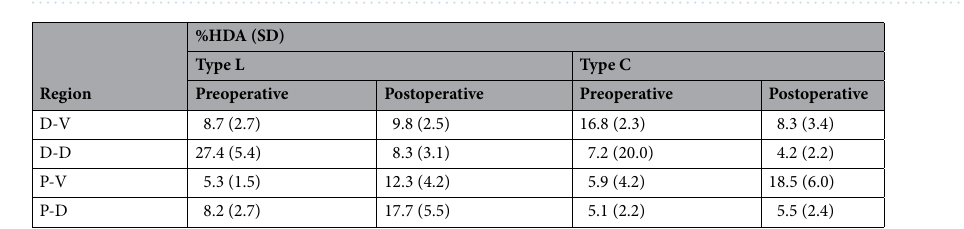
Figure 4. Distribution patterns of percentage high-density areas (%HDA) in type L and type C before and after surgery. The distribution of HDA in each region is shown schematically in the red circle in the figure. D-V Distal-volar, D-D Distal-dorsal, P-V Proximal-volar, P-D Proximal-dorsal. Statistical analysis was performed using the Kruskal–Wallis test (* p < 0.05).